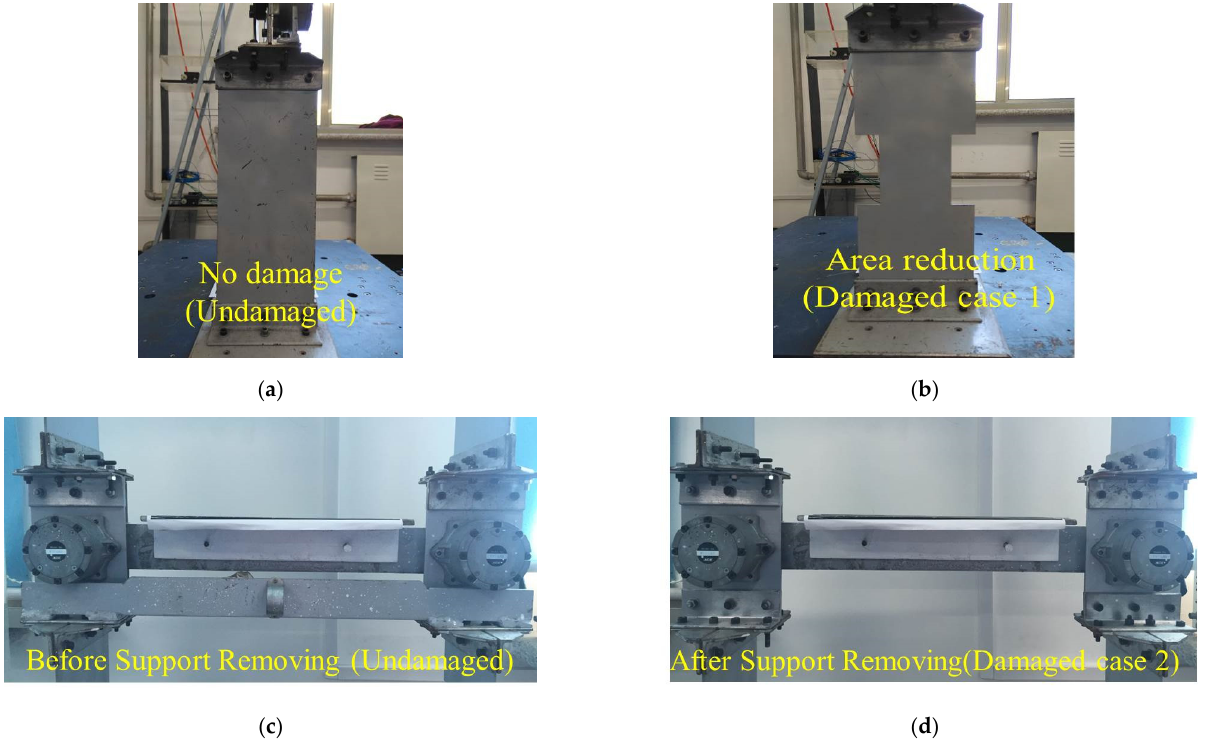
Figure 3. The pictures show the ( a ) undamaged steel frame; ( b ) damaged case 1 with a reduction in the area of the column; ( c ) undamaged frame, the same as that shown in ( a ); ( d ) damaged case 2, with the rigid beam removed from the first floor.